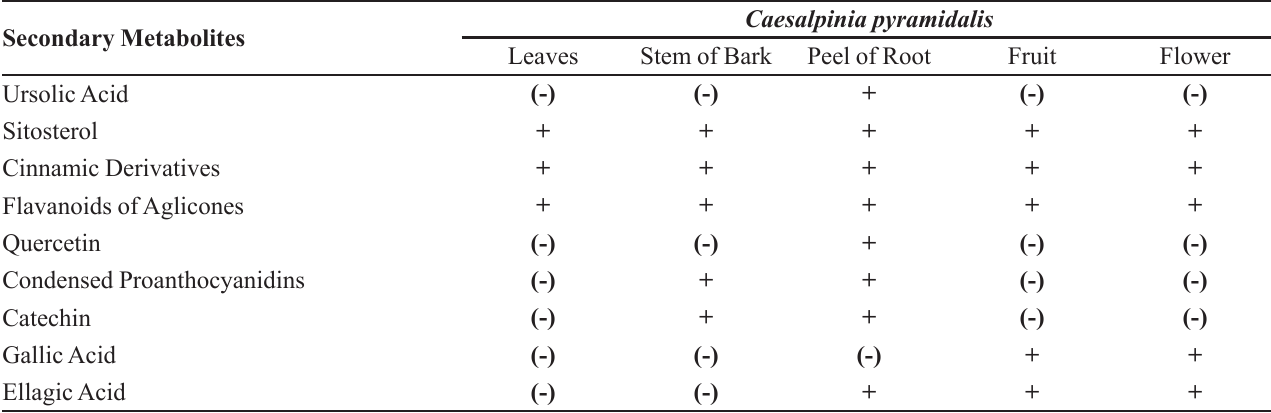
TABLE VI - Secondary metabolites from Caesalpinia pyramidalis with well-known antimicrobial activity Secondary